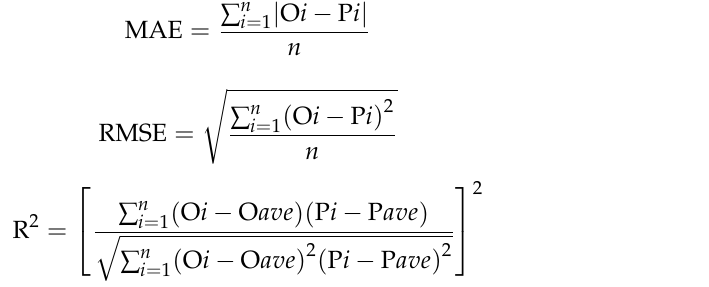
Figure 4. Comparison of model evaluation parameters: ( a ) root mean square error (RMSE), ( b ) coef- fi cient of determination (R 2 ), ( c ) mean absolute error (MAE). Calculations were performed over 10 iterations. The mean RMSE values for CEC according to cross-validation statistics of the models ranged from 4.12 to 5.07, while R 2 values ranged from 0.25 to 0.41 and MAE values ranged from 3.12 to 4.01, as shown in Table 3. Figure 4 displays the variation in R 2 , MAE, and RMSE values during cross-validation of the models. The RF model outperformed the other models, demonstrating lower RMSE and MAE values, and higher R 2 values compared to the other models as shown in Table 3 and Figure 4. The standard deviations of these per- formance criteria were highest with LR (0.75, 0.16, and 0.55 for RMSE, R 2 , and MAE, re- spectively) (Table 3).